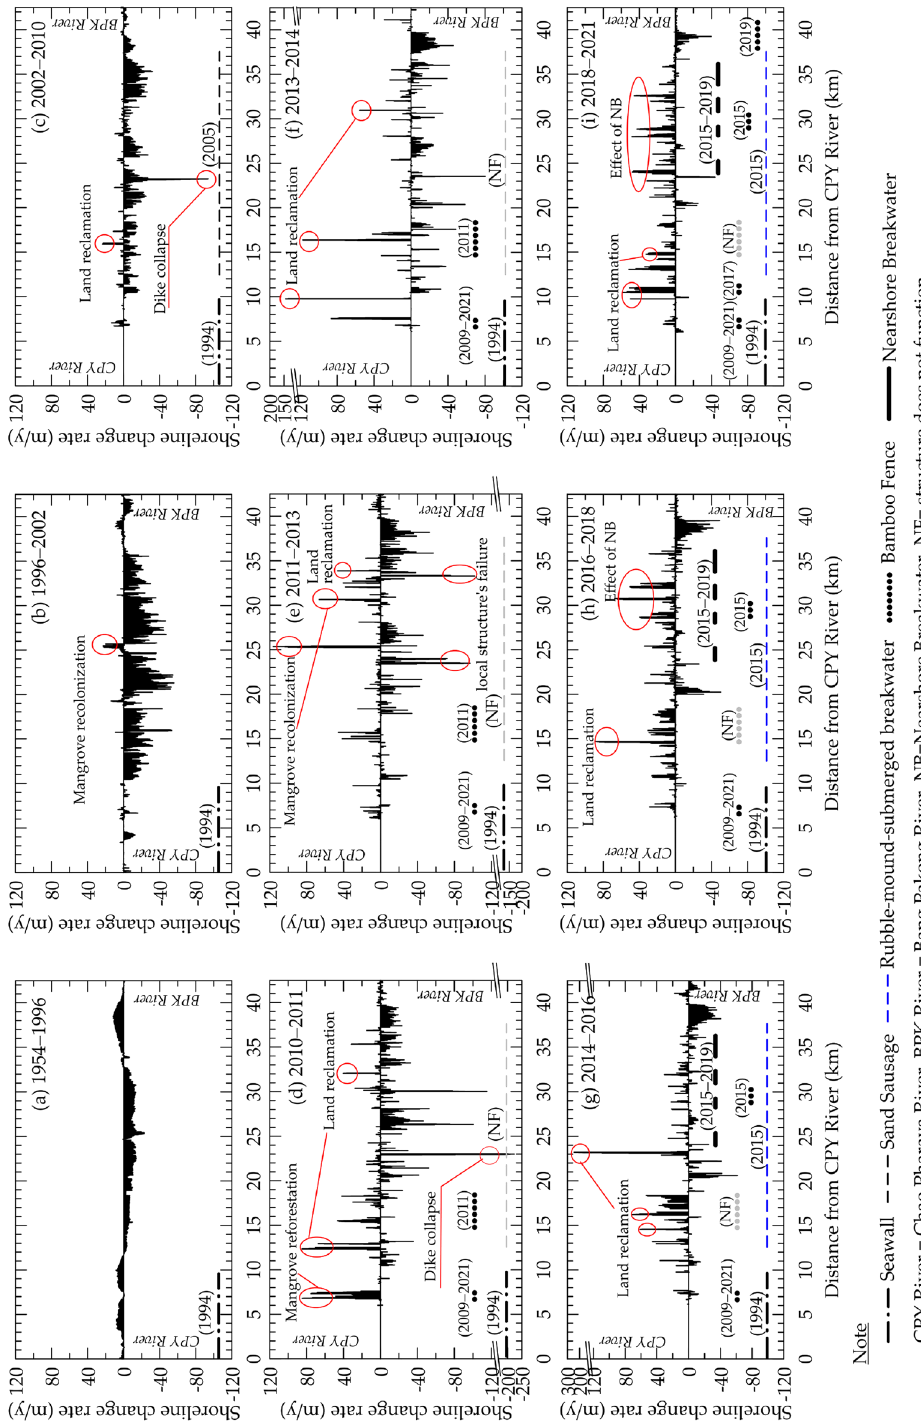
Figure 2. Long-term and short-term (interannual) shoreline change rates on the eastern Chao Phraya Delta (ECPD) coastline during